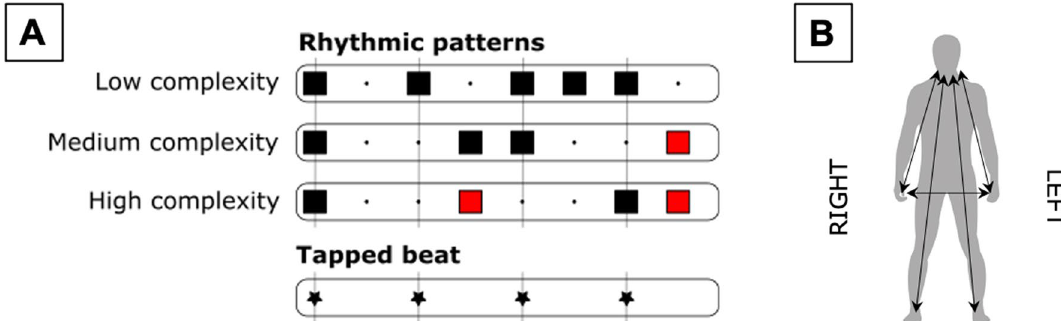
Figure 2. Experimental stimuli and conditions. ( A ) Transcription of the rhythmic patterns used for the three subtests. ( B ) The effector combinations used in the experiment: V + RH, V + LH, V + RF, V + LF, RH + LH, and RH + LF, each in their dominant and non-dominant version respectively. Syncopes are highlighted in red to emphasize the difference in difficulty. Figure was created using Inkscape 1.1 (https:// inksc ape. org), Adobe Illustrator 2018 22.0.0 (https:// www. adobe. com/ produ cts/ illus trator. html) and Microsoft Word for Mac, version 16.49 (21,050,901) (https:// www. micro soft. com/ da- dk/ micro soft- 365/